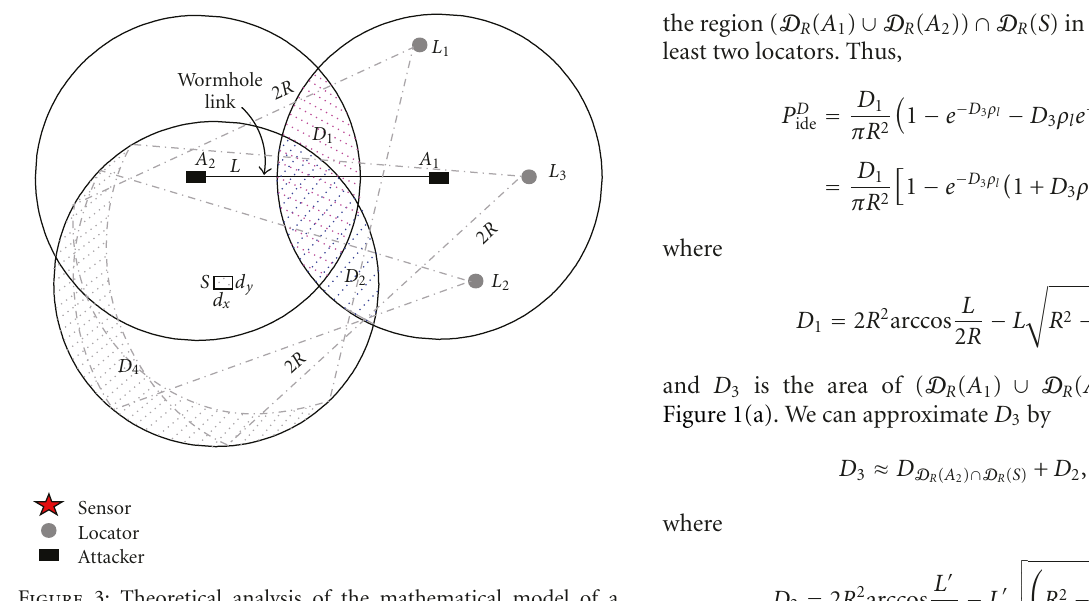
Figure 3: Theoretical analysis of the mathematical model of a wormhole